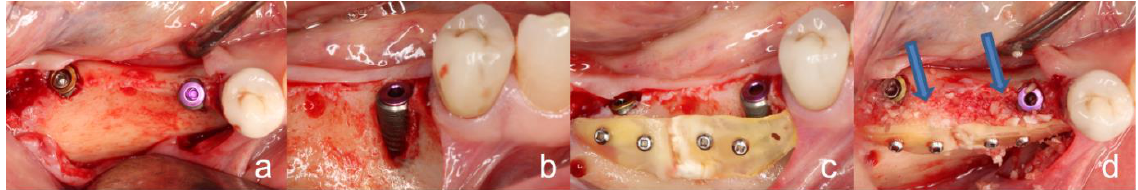
Figure 2. Surgical procedure of the tooth shell technique. ( a , b ): Occlusal and lateral view: inserted implants in regions 45 and 47. The vestibular implant surface of region 45 was not covered with bone. ( c ): Vestibular of the two implants, two dentin shells were fixed with four osteosynthesis screws. ( d ): The created cavity between the dentin shells and the residual bone or implants were filled with particulate dentin (blue arrows).